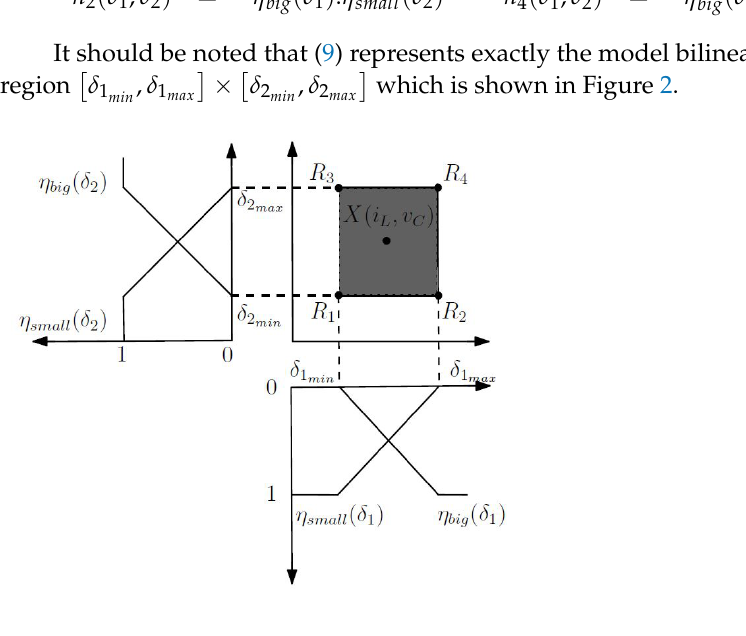
Figure 2. T-S Fuzzy representation of the buck-boost converter.